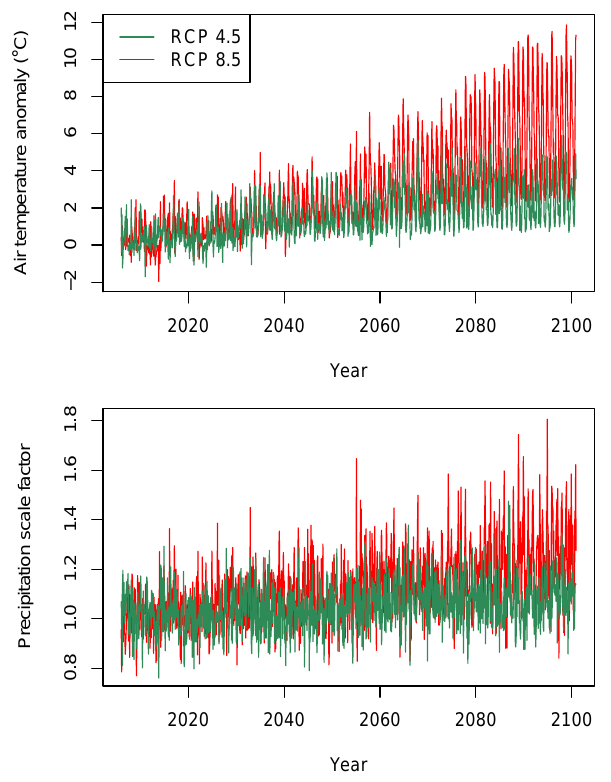
Figure 3. CCSM4 anomalies for air temperature and precipitation. Values given are the areal mean for the region north of 25 ◦ latitude (the same region as the JULES